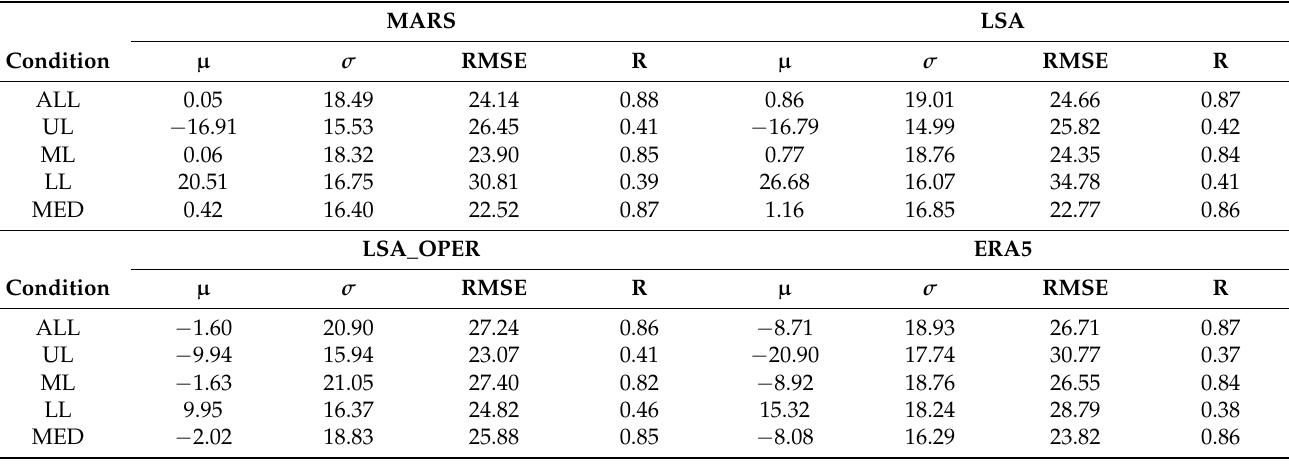
Table A9. Comparison of bias ( µ ), standard deviation of the error ( σ ), root mean square error (RMSE), and temporal correlation coefficient (R) between different models (MARS, LSA, LSA_OPER, and ERA5) and observations from all 52 FLUXNET2015 ground stations for all-sky (2004–2015) in different conditions: considering all data (ALL); observations with values above 400 W · m − 2 (UL); observations with values between 200–400 W · m − 2 (ML); observations with values below 200 W · m − 2 (LL); and the median of the distribution of the metrics computed independently for each station (MED). Units are in W · m − 2 , while correlations are given between